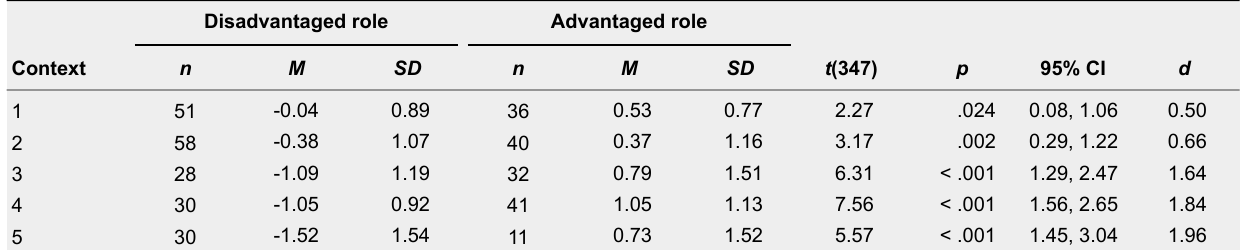
Means and Standard Deviations of Perceived Social Role and Effect Sizes of the Social Role Manipulation (Study 1)